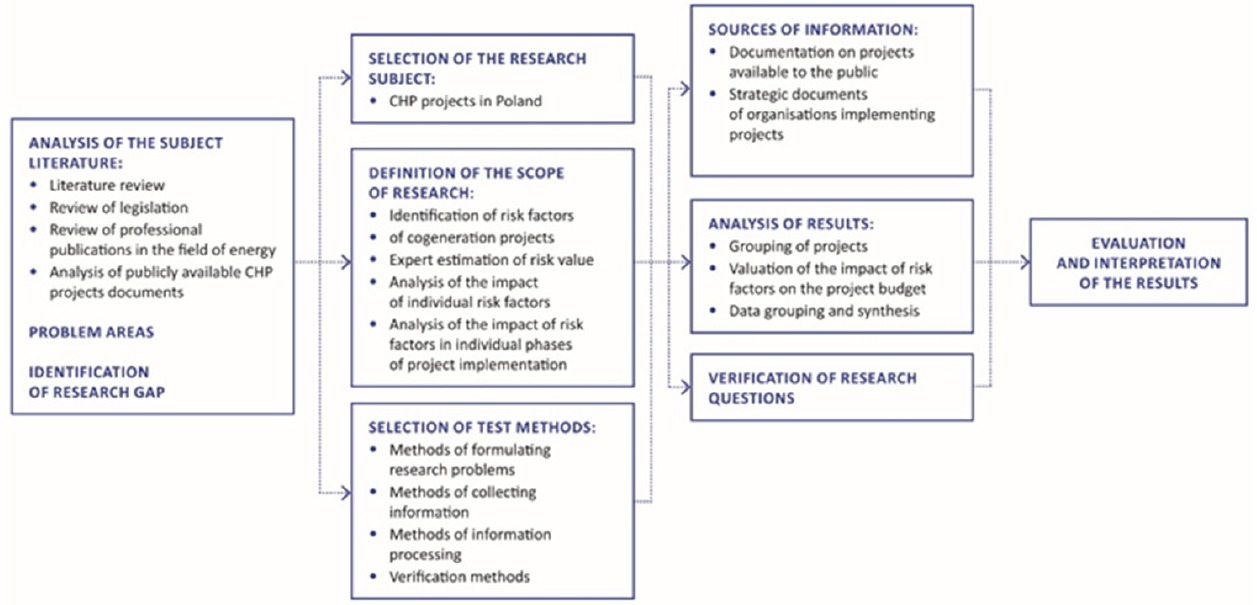
Figure 3. Research concept. Source: our own study.